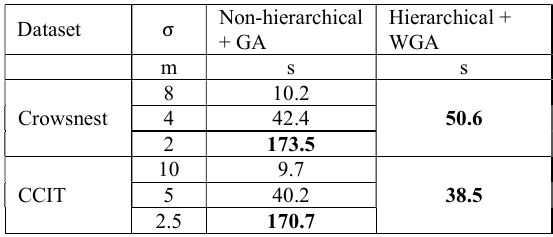
Table 4. Runtime for methods with different resolutions